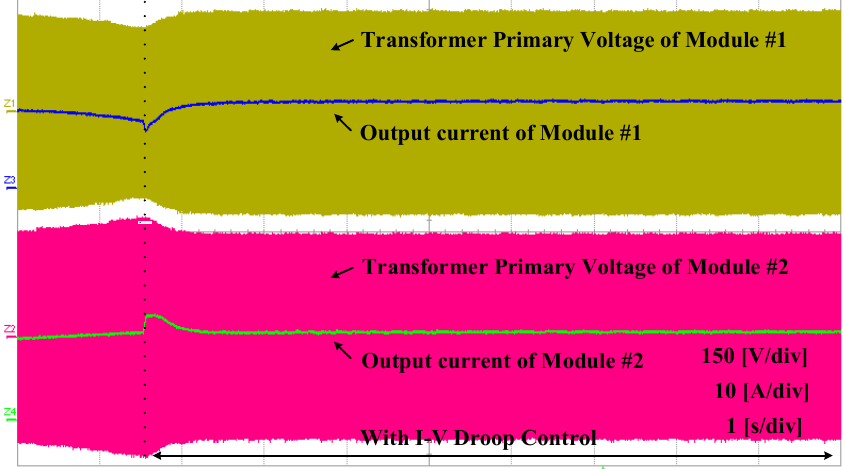
Figure 11. Experimental waveform from Individual primary voltage of transformer and output current.